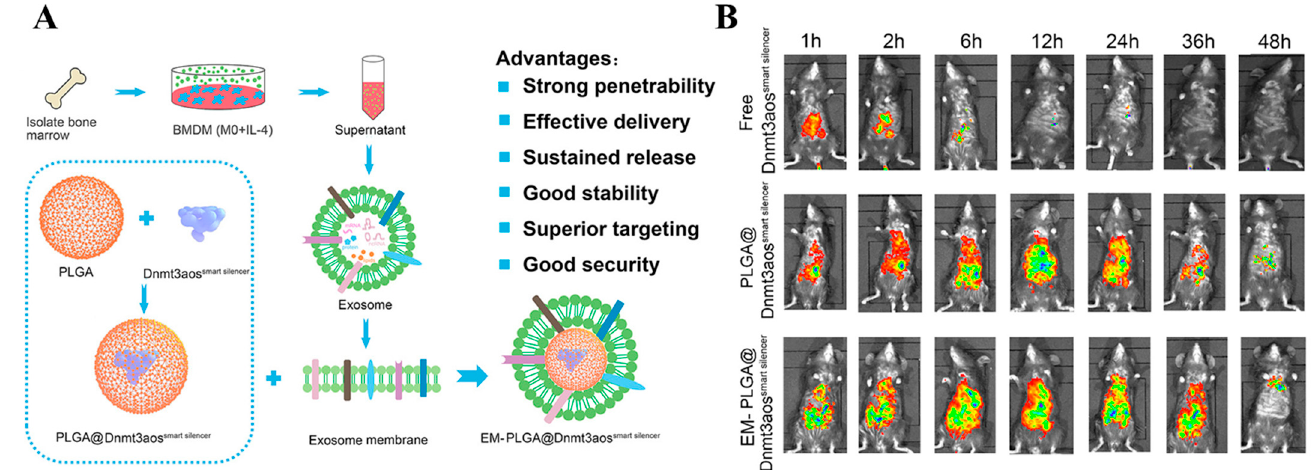
Figure 7. ( A ) The schematic representation of EM-PLGA@Dnmt3aos smart silencer . ( B ) In vivo tracking and tissue distribution of EM-PLGA@Dnmt3aos smart silencer in mice. Reproduced with permission from [51] © 2022.Elsevier B.V.